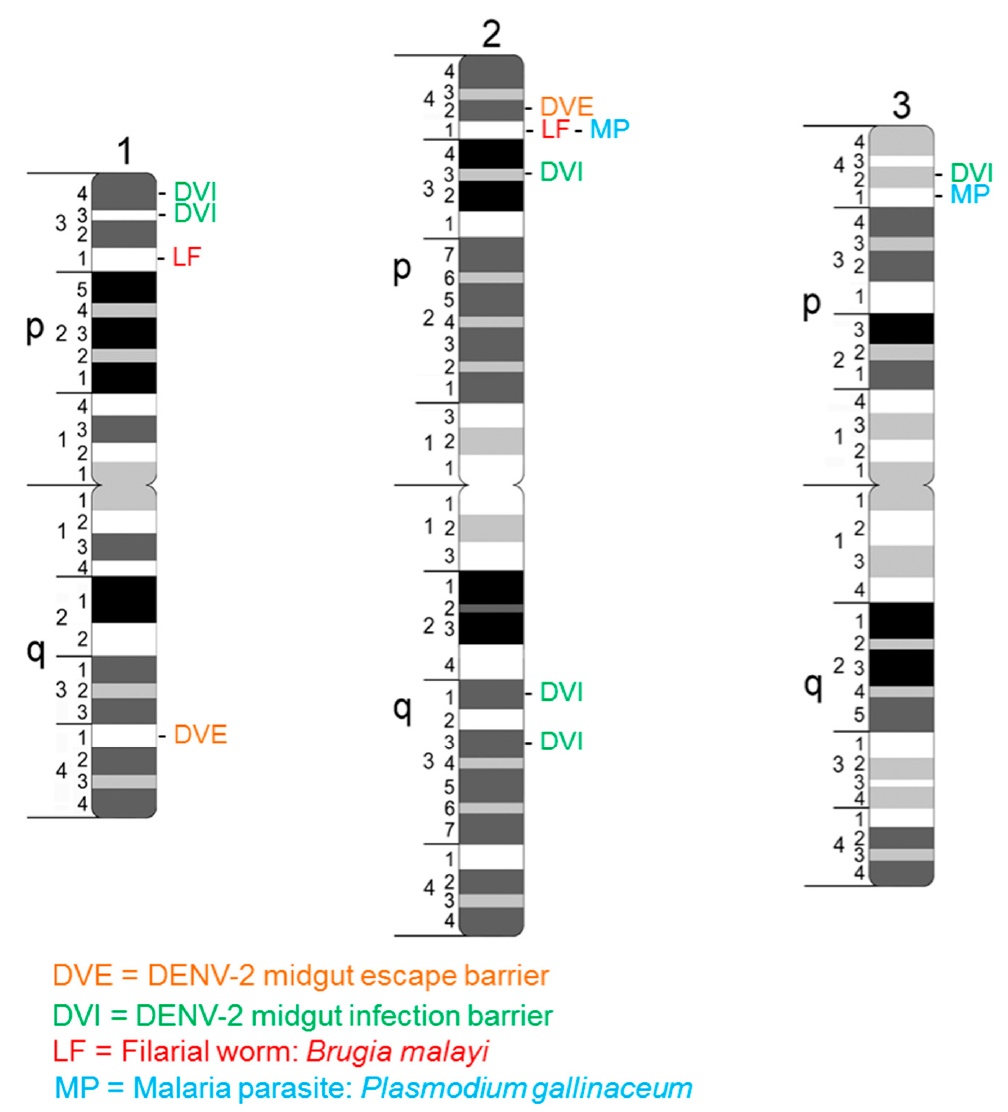
Figure 1. Physical chromosome locations of anchor markers for QTL conditioning vector competence to DENV-2, the protozoan parasite Plasmodium gallinaceum , and the metazoan parasite Brugia malayi . Adapted from [77].